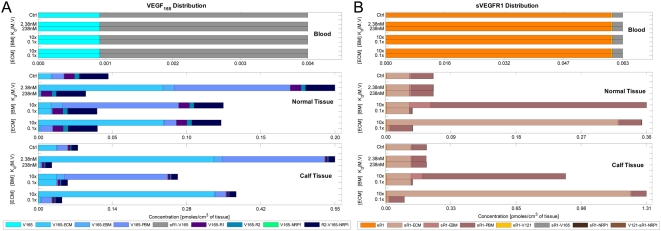
Sensitivity to Density & VEGF-Binding Affinity of Interstitial Matrix Sites for VEGF165 & sVEGFR1.Steady-state sensitivity of VEGF165 (A) and sVEGFR1 (B) distributions in blood (top), normal tissue (middle) and calf tissue (bottom) compartments to the VEGF165-binding affinity (Kd(M,V)) and densities ([ECM]; [BM]) of interstitial matrix sites. At control: Kd(M,V) = 23.8 nM; [ECM] = 20 µM; [BM] = 0.75 µM. Concentrations of soluble species (e.g., free VEGF165, free sVEGFR1, sVEGFR1-VEGF165) and surface VEGFR occupancies (e.g., VEGF165-VEGFR1, VEGF165-VEGFR2, VEGFR2-VEGF165-NRP1) were completely insensitive; whereas the sizes of matrix-bound reservoirs of VEGF165 and sVEGFR1 (e.g., VEGF165-ECM, sVEGFR1-PBM) were greatly affected. ‘Kd(M,V)’ = dissociation constant between interstitial matrix sites and VEGF165; ‘[ECM]’ and ‘[BM]’ = densities of binding sites for VEGF or sVEGFR1 in extracellular matrix and basement membranes respectively’; ‘Ctrl’ = control; ‘PBM’ = parenchymal BM; ‘EBM’ = endothelial BM; V165 = VEGF165; ‘R1’ = VEGFR1; ‘sR1’ = sVEGFR1; ‘R2’ = VEGFR2.